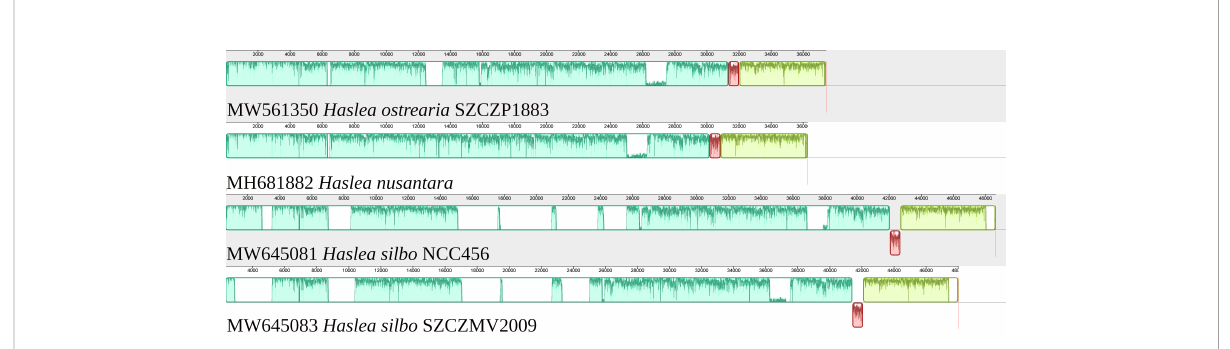
FIGURE 4 MAUVE alignment of the mitogenomes of Haslea ostrearia SZCZP1883, Haslea silbo and Haslea nusantara. There were 3 blocks of synteny detected by MAUVE. The red block is located on the opposite strand in H. silbo compared to the two other species and corresponds to a non- conserved